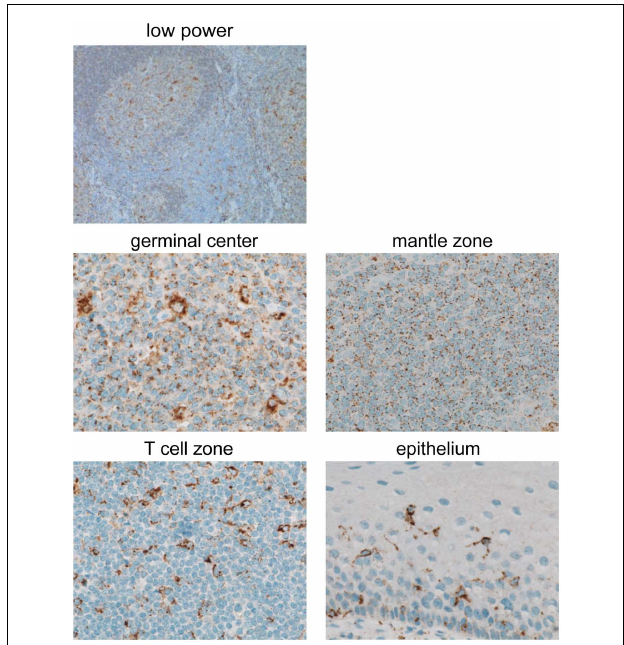
FIGURE 4 | GILT protein is expressed in B cells andAPCs in benign tonsil . GILT expression in normal human tonsil shown with a low power view (original magnification, × 100) and in the germinal center, mantle zone, T cell zone, and epithelium (original magnification, × 600). Images were acquired using a Nikon ECLIPSE 80i microscope with a 10 × /0.30 or 60 × /0.95 objective lenses, a Nikon DS-Ri1 camera and Nikon NIS-Elements Imaging software